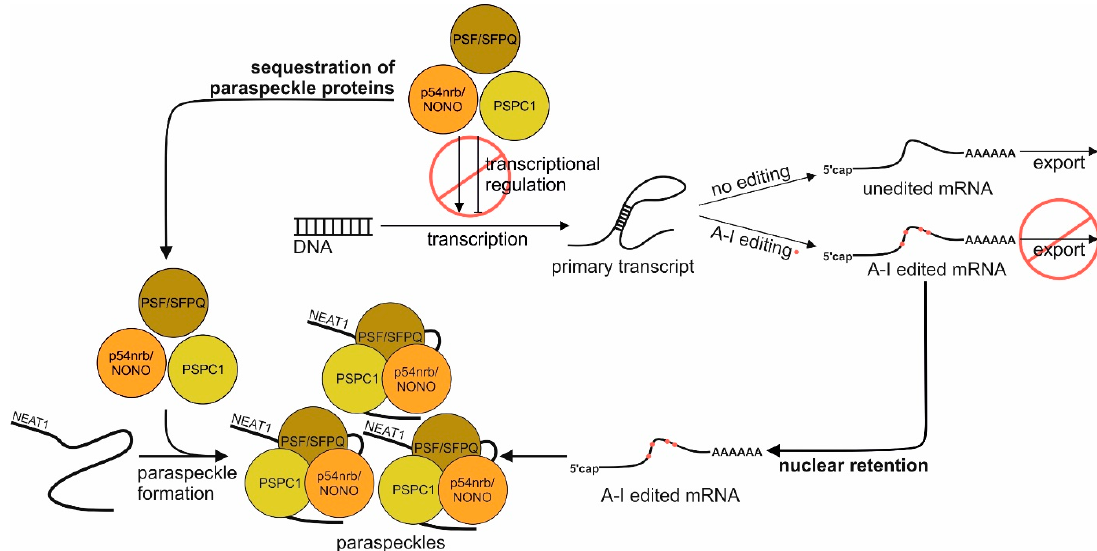
Figure 2. Role of NEAT1 in the regulation of gene expression. NEAT1 influences gene regulation through two predominant functions. On one hand, NEAT1 -dependent paraspeckle formation leads to the sequestration of paraspeckle proteins such as PSPC1, PSF/SFPQ, and p54nrb/NONO, therefore limiting their effect on the transcriptional regulation. On the other hand, adenosine-to-inosine (A–I) edited mRNAs are more efficiently bound by formed paraspeckles and in turn more effectively retained in the nucleus, instead of being transported to the cytoplasm.